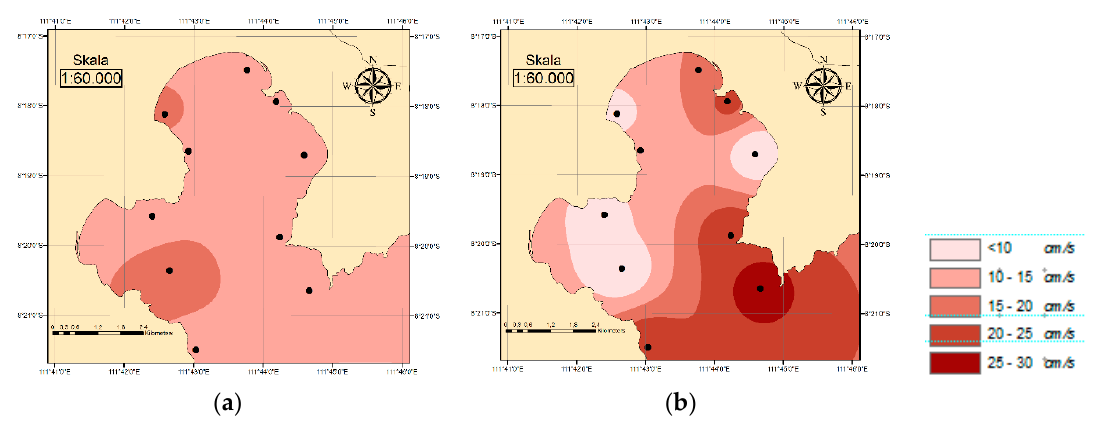
Figure 4. Distribution of Current Velocity ( a ) March ( b ) October 2016.